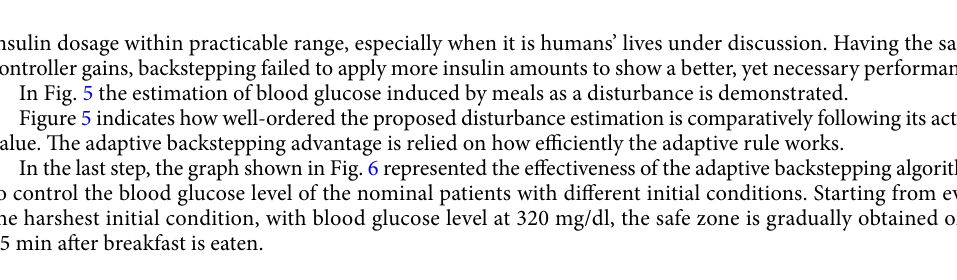
Figure 6. Blood glucose control with different initial conditions under the proposed control